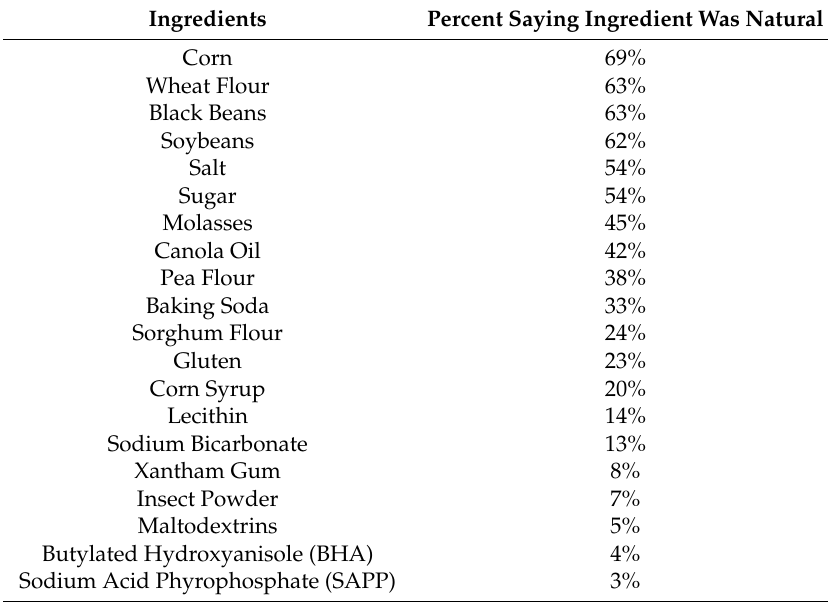
Table 2. Percentage of people saying that an ingredient was